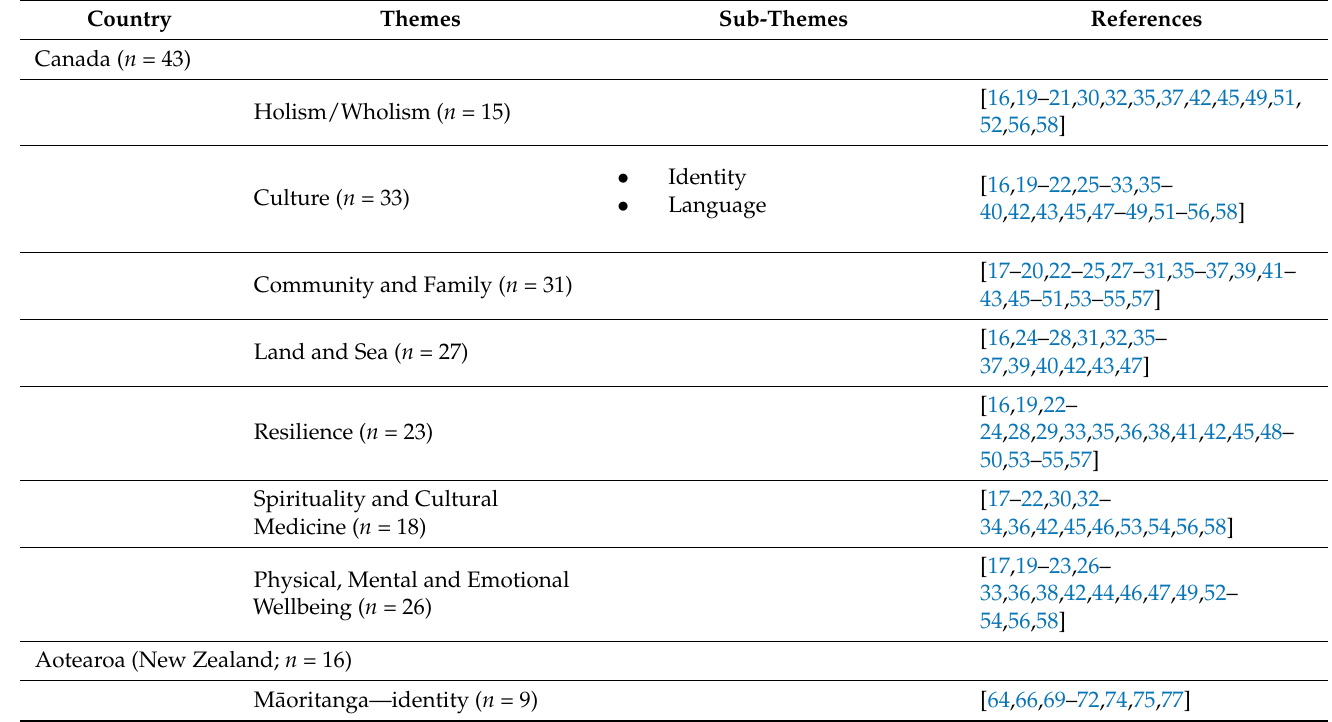
Table 2. Summary of themes and sub-themes of wellbeing by country.